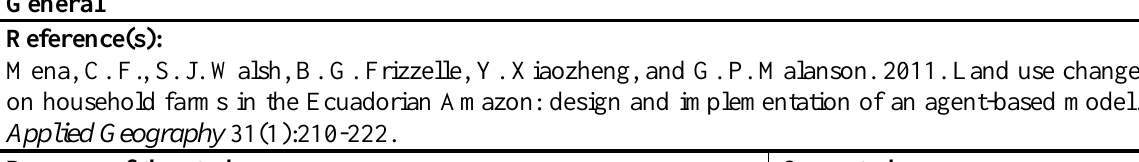
Table A1.7 Standardized protocol for the ABM described by Mena et al.